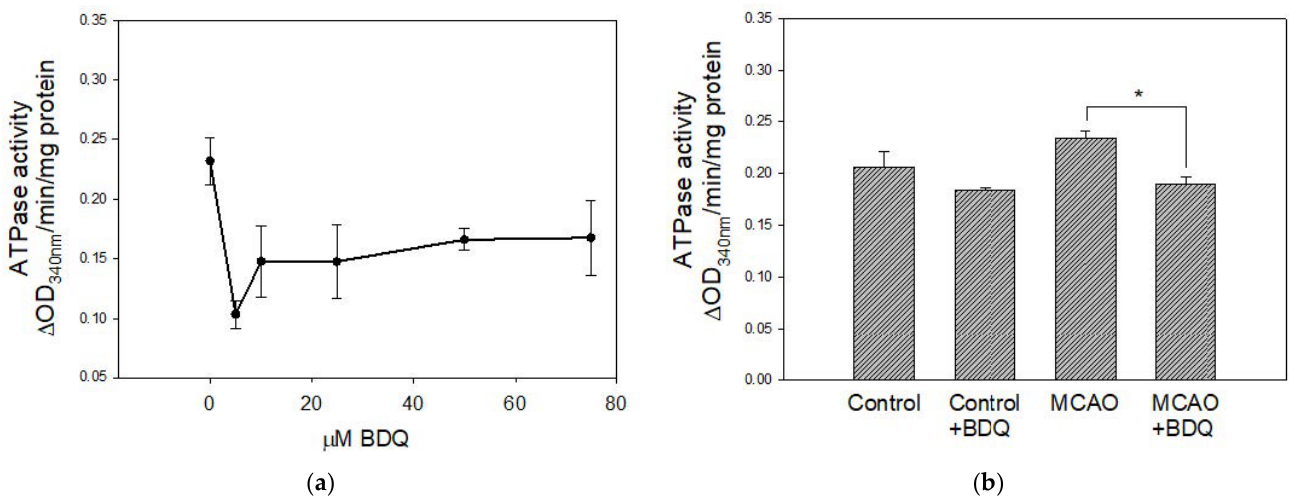
Figure 3. Effect of BDQ on ATPase activity. ( a )—The direct effect of BDQ on ATPase activity in isolated normal brain mitochondria. BDQ in all concentrations significantly decreased ATPase activity ( p < 0.05). The extent of inhibition between different concentrations of BDQ did not differ significantly ( p ≥ 0.05). ( b )—The effect of BDQ, injected into rats prior to MCAO or 24 h before euthanasia, on the activity of ATPase in isolated mitochondria. Data are presented as mean ± SEM of 3–6 experiments on individual animals. *—Statistically significant difference ( p < 0.05).